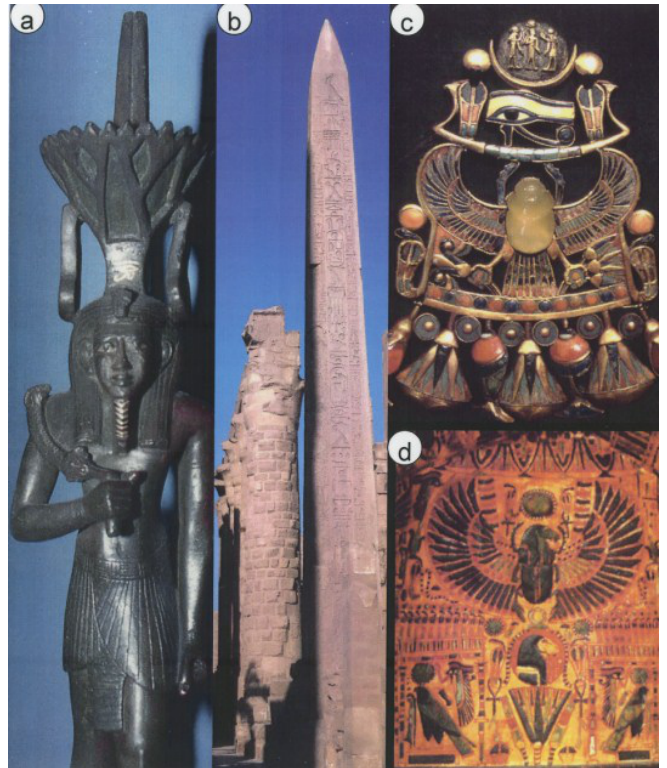
Figure 1. The cosmogenic Nilotic lotus. ( a ) Although Nefertum leads the Heliopolitan pantheon during the Old Kingdom, personified images of the lotus god occur commonly during the New Kingdom and Ptolemaic periods. Egypt, ca. 3rd c. BCE (Metropolitan Museum). ( b ) The Egyptian obelisk, a phallic symbol of Osiris-Ra, frequently bears at its apex the avian image of his solar offspring, Horus. Here, the pillar surpasses in height the massive papyrus columns of Karnak. Egypt, Karnak, 15th c. BCE. ( c ) Khepri lifts the lapis lazuli boat of Horus’s solar eye out of a lotus grove. The divine scarab, a mythic image of the lotus-god, Nefertum, also carries two symbols of immortal life within his talons: shen loops and a cluster of two lotus buds and blossom. Thebes, Valley of the Kings, Tomb of Tutankhamen, 14th c. BCE (Cairo Museum). ( d ) A ram-headed scarab beetle with blue wings emerges from a lotus blossom to push forth the flower’s golden disk. A pair of cobras (uraei) dangle from the solar-floral disk, each upholding an ankh. The latter symbols complement the flanking pair of lotus buds to either side of the blossom, as well as paired avian images of Horus (blue falcons) yet to take flight. Egypt, coffin of Pameshen, ca. 10th c. BCE (Cairo